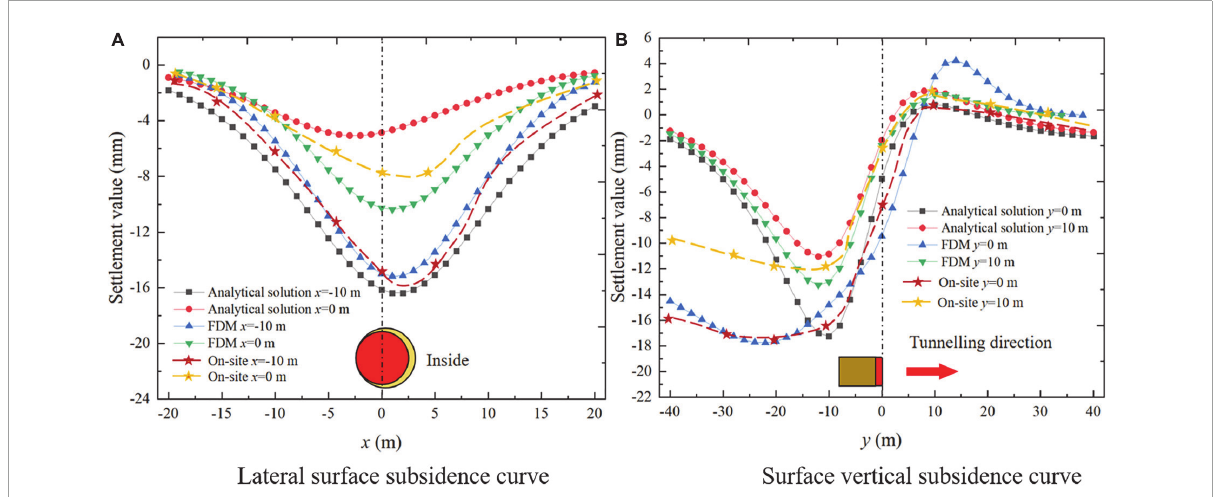
FIGURE7 Surface subsidence curve. (A) Lateral surface subsidence curve and (B) surface vertical subsidence